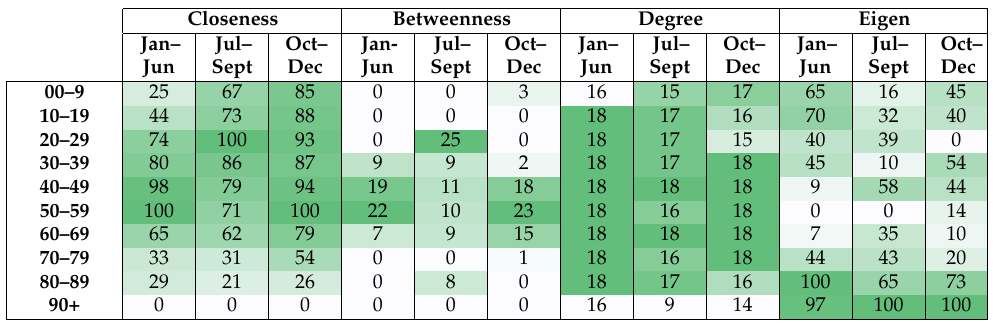
Table 6. Centrality Measures of the digraph related to the Age groups Jan–Jun, Jul–Sept and Oct–Dec time intervals of